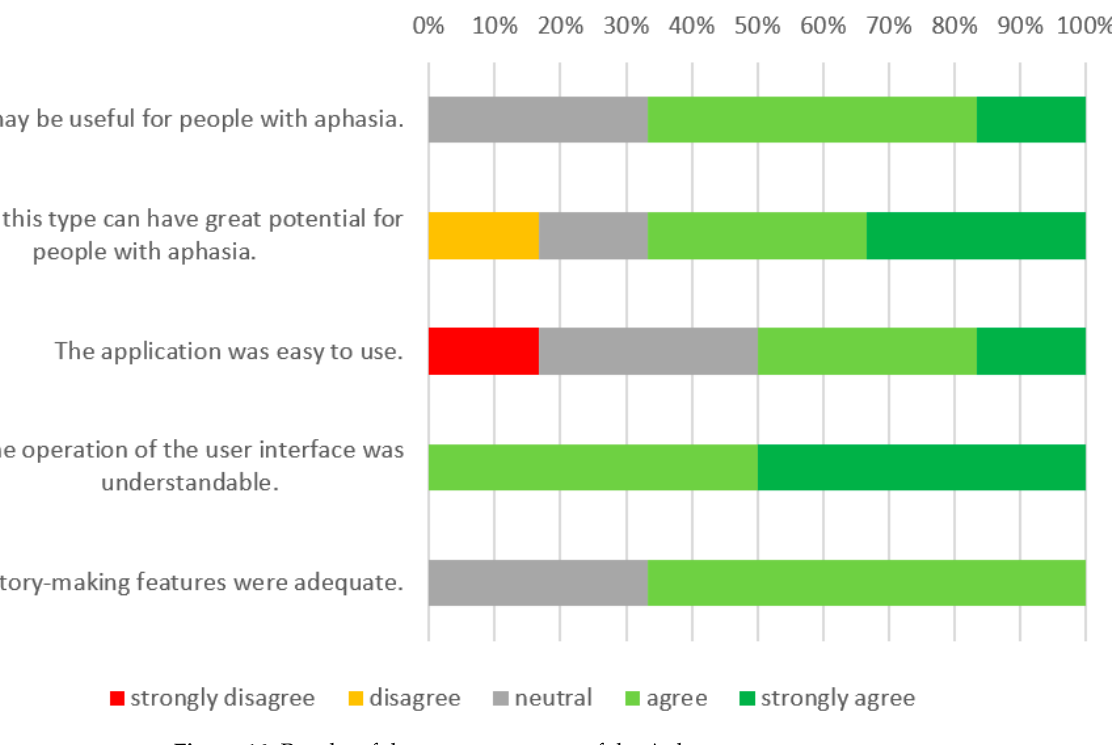
Figure 16. Results of the post-survey test of the Aphastory app.